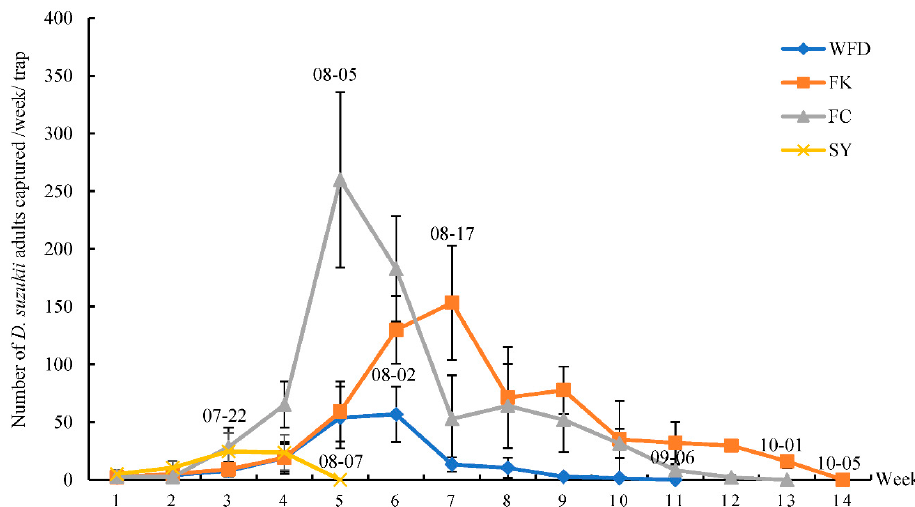
Figure 5. Mean number of D. suzukii captured per week per trap at the different locations. The numbers on the curves indicate the sampling date (month-day). In WFD, 1–11 weeks start from 06-21 to 09-06. In FK, 1–14 weeks start from 06-22 to 09-28. In FC, 1–13 weeks start from 06-26 to 10-01. In SY, 1–5 weeks start from 07-02 to 08-06. The relative abundances of D. suzukii adults captured were not significant different between commercial fields and woods/wild bushes in WFD (F = 0.001, df = 1, 20, p > 0.05), FK (F = 3.985, df = 1, 24, p > 0.05), FC (F = 2.178, df = 1, 24, p > 0.05), and SY (F = 0.189, df = 1, 6, p > 0.05) (Figure 6, Supplementary Data S1).